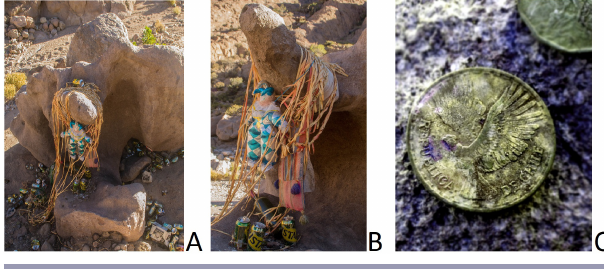
Fig. 2 . Condor Stone, Tignamar, northern Chile. (A) In the center, the head with streamers around the neck and below, the table for offerings, surrounded by bottles and cans of alcohol. (B) Detail of the neck with streamers around it; in front, a clown doll and, below it, a chuspa , a traditional woven bag, containing banknotes and coca leaves. (C) Old Chilean coins that are no longer legal tender with images of the condor that have been left as offerings (Photos by Andrés Jacques